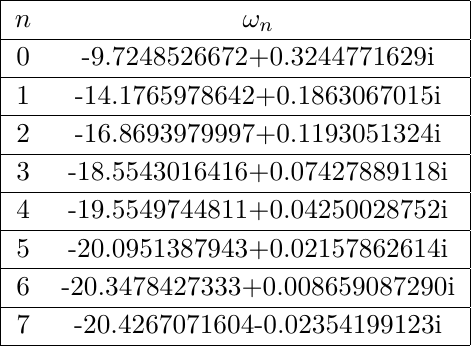
(blue line), ψ (brown line), and ψ (green line) (0) (1) (2)